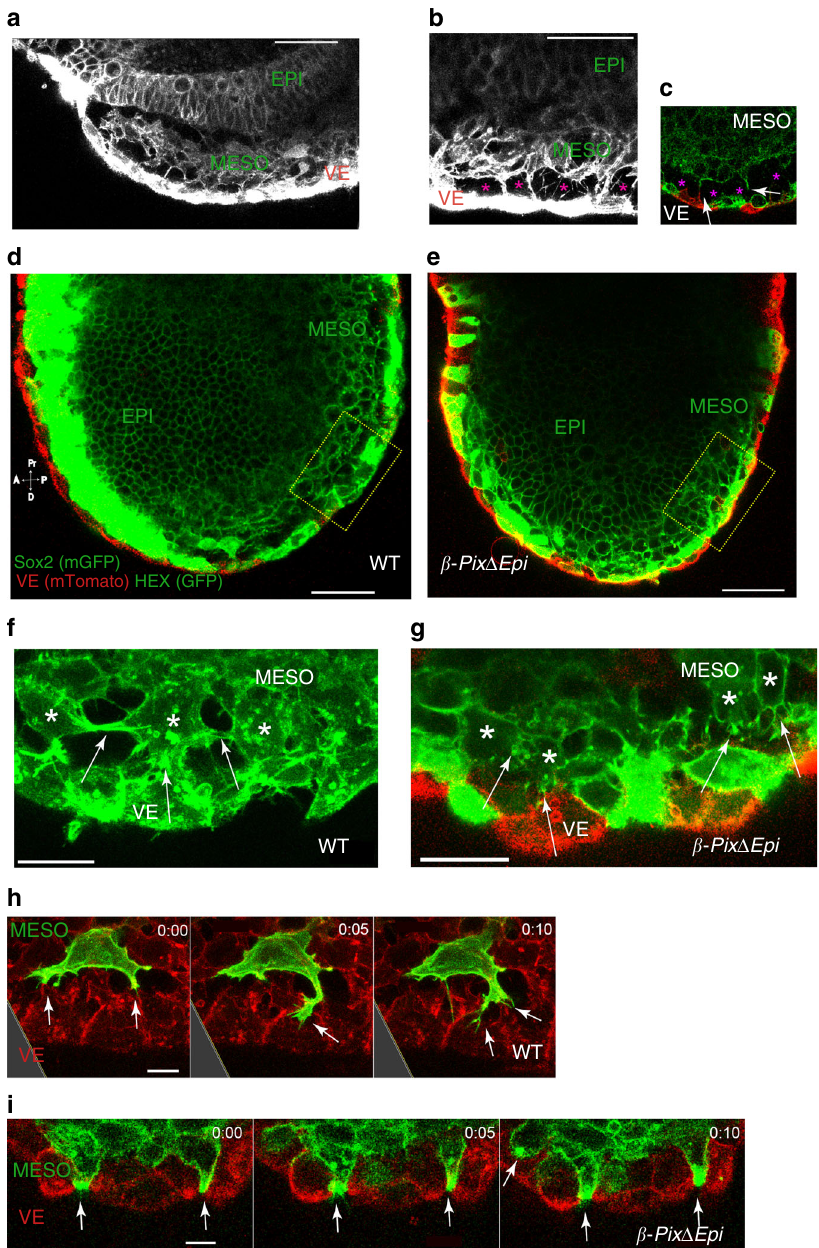
Fig. 4 β -Pix is required for directional cellular protrusions in mesoderm cells. a , b Rendered transverse confocal sections of live embryo expressing mGFP and the visceral endoderm marker Hex-GFP show the mesodermal layer sandwiched between the VE and EPI. c – e Rendered sagittal confocal images of live E7.5 embryos expressing mTomato in all VE cells and mGFP in the epiblast (EPI) and mesoderm cells (MESO). Most HEX-GFP cells are on the anterior side. ROI is highlighted. Note cellular protrusions (arrows) emanate from VE and MESO ( c ). Space between VE and MESO labeled with magenta asterisks. f , g Cellular protrusions (arrows) from mesoderm cells in ROIs from d , e . h , i Time-lapse snapshots of cell protrusions (arrows) from wild-type mesoderm cells at the MESO-VE interface demonstrate long, transient protrusions ( e ). Mutant cells at the MESO-VE interface have less dynamic, shorter protrusions with punctate accumulation of mGFP ( f ). Scale bar, 30 µ m ( a – e ), 10 µ m ( f , g ), 5 µ m ( h , i ). The images are representative and are from n > 3 embryos for wild type or mutant genotype ( a – i ). Time scale, the data suggest that β -Pix restricts the zone of protrusive activity, which allows directional migration of nascent mesoderm cells.